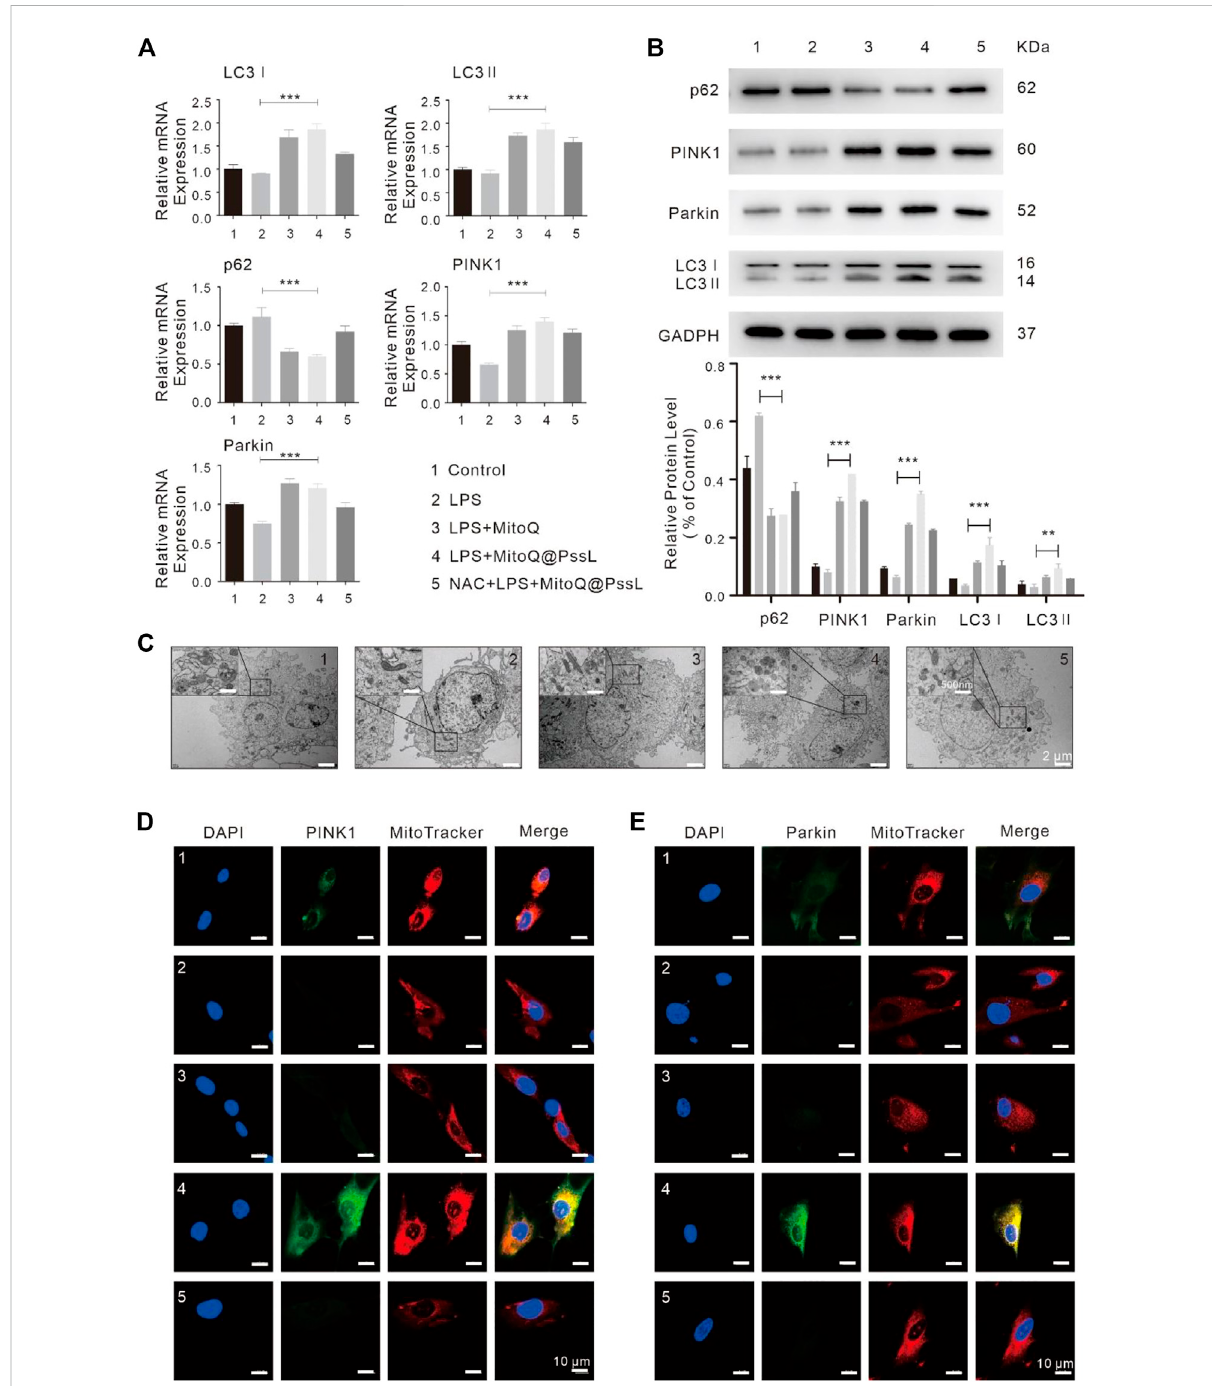
FIGURE 2 MitoQ@PssL NPs signi fi cantly promoted mitophagy and upregulated the PINK1-Parkin pathway in LPS-induced hPDLSCs (1: Control, 2: LPS, 3: LPS + MitoQ, 4: LPS + MitoQ@PssL NPs, and 5: NAC + LPS + MitoQ@PssL NPs). (A) The expression of PINK1, Parkin, LC3I, LC3 II and p62 were detected using RT-PCR. (B) The expression of PINK1, Parkin, LC3I, LC3II and p62 were detected using western blot analysis. (C) Representative TEM images of mitochondrial morphology in hPDLSCs. Scale bar: 2 μ m. Partial enlargements were shown in the black boxes. Scale bar: 500 nm. Mitochondrial morphology and the colocalization of the mitochondrial with (D) PINK1 (E) Parkin were analyzed using a 63× oil immersion lens (630×). Scale bar = 10 nm. (* means p < .05, ** means p < .01, *** means p <